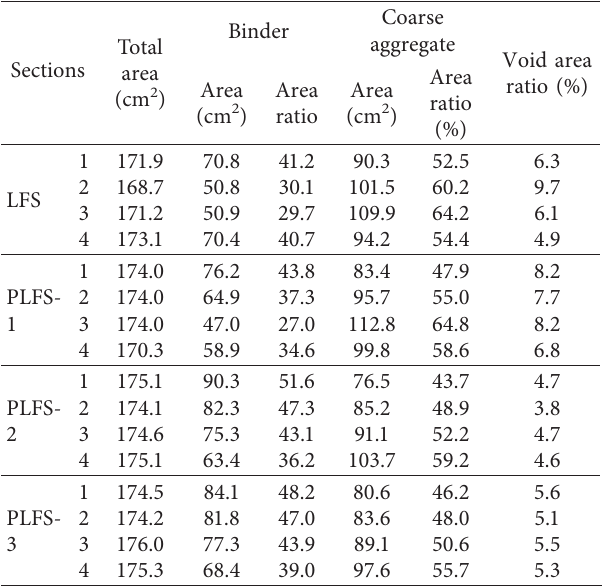
Figure 7: The second section of different solidified materials. (a) LFS. (b) PLFS-1. (c) PLFS-2. (d) PLFS-3. Table 3: Calculation of the composition structures.